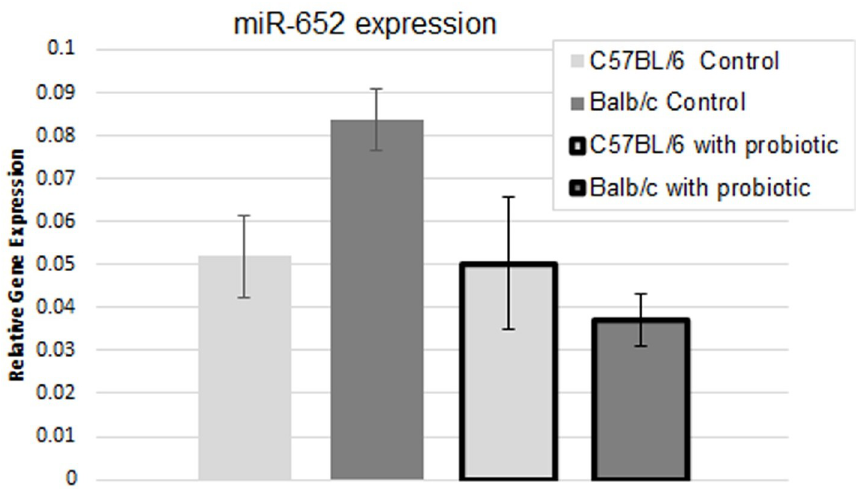
Fig 4. Expression of mmu-mir-652-3p in the brains of mice with and without B . longum treatment. Expression of mmu-mir-652-3p in the brains of Balb/c and C57BL/6 mice was measured using a qPCR. Values are relative to Hs- RNU6-2 and error bars represent one standard deviation. The change in expression in the Balb/c mice is statistically significant (p < 0.05). n = 4 per bar.